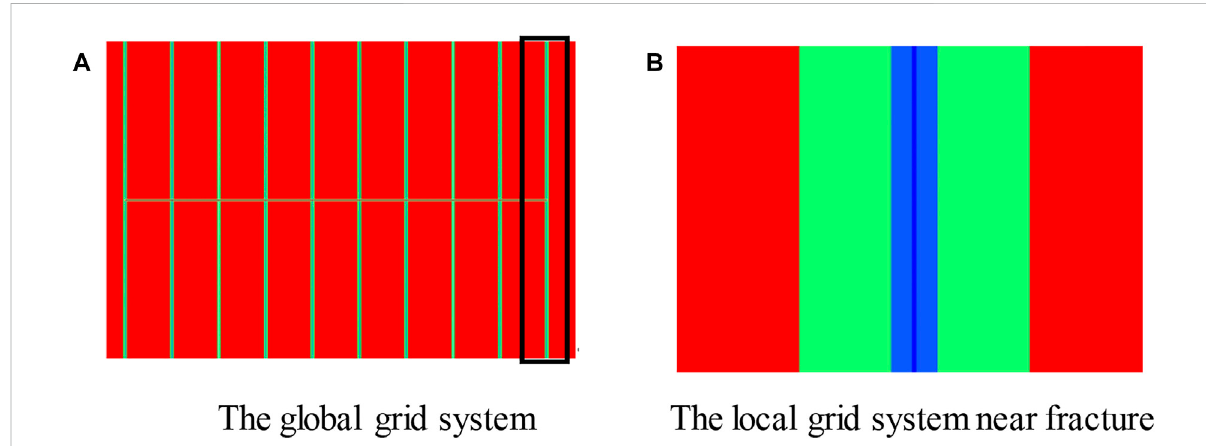
FIGURE 4 The grid system of the numerical model. (A) The global grid system. (B) The local grid system near a fracture.